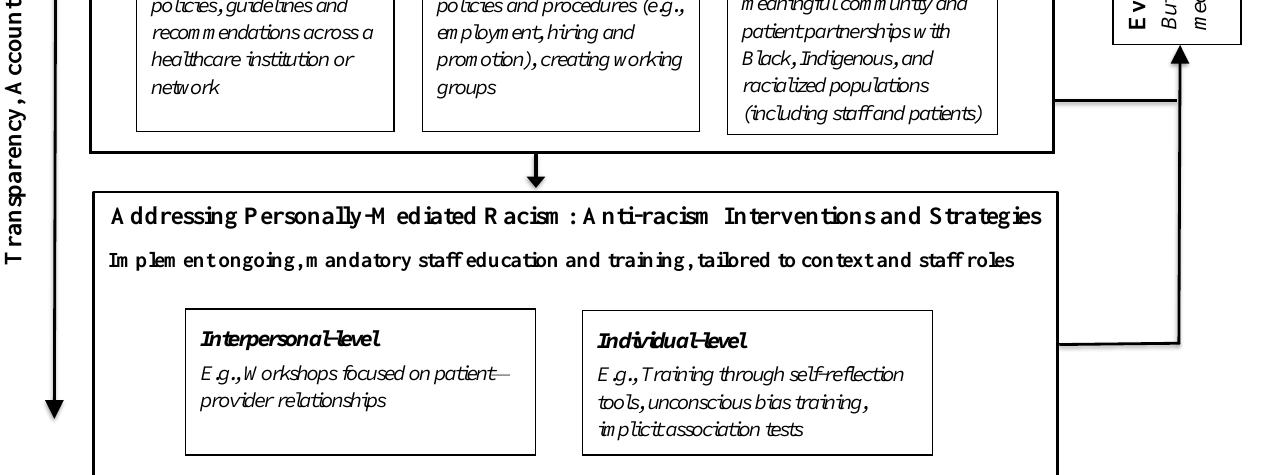
Addressing Institutional Racism: Anti-racism Interventions and Strategies Use a multi-level, multi-pronged approach for long-term change. Start with broad-level interventions (i.e. policy and organizational-level interventions with community input) Policy-level